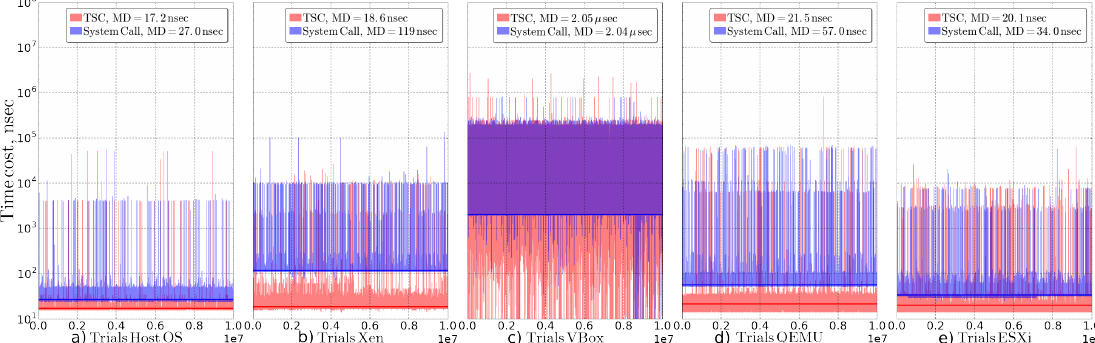
Figure 4. Measurements of timer cost for the Idle testbed on: ( a ) Host OS; ( b ) Xen; ( c ) Virtual Box; ( d ) QEMU; and ( e ) VMware